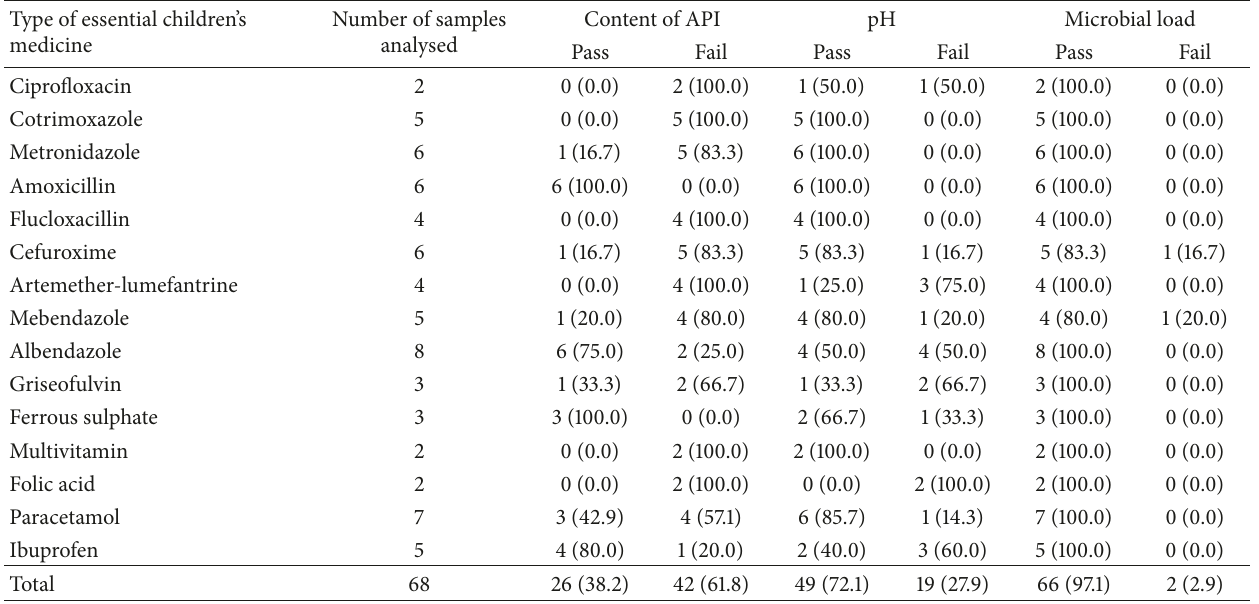
Table 3: Summary results of the quality of essential children’s medicines investigated based on content of API, pH, and microbial load. Type of essential children’s